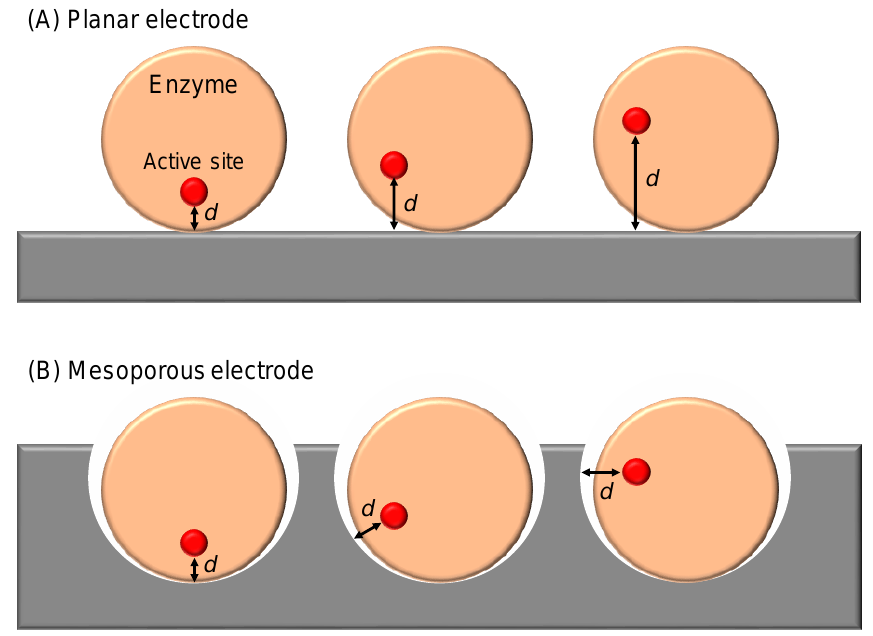
Figure 2. Schematic of the enzyme orientations at the ( A ) planar and ( B ) mesoporous electrodes.